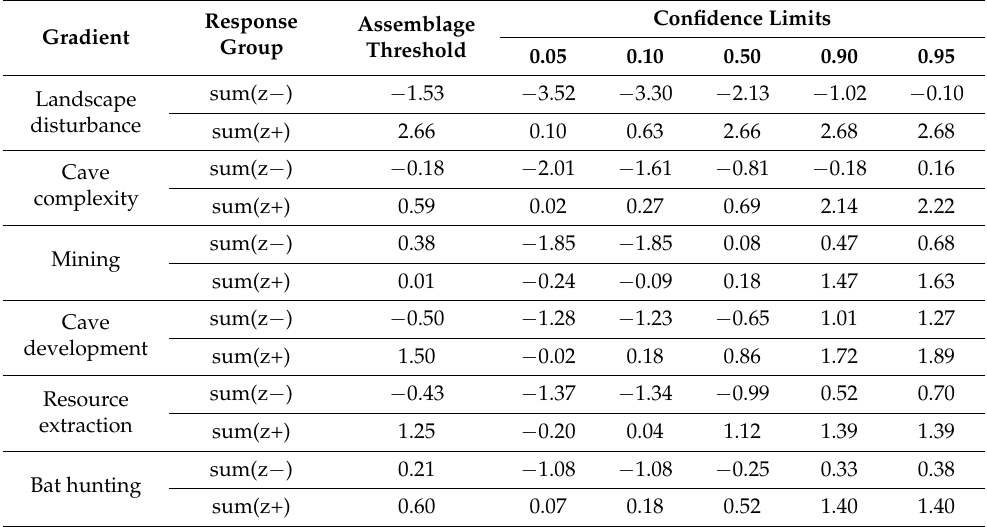
each group used to identify threshold values along each gradient. Confidence limits correspond to the cumulative frequency distribution of assemblage thresholds resulting from 500 replicates.